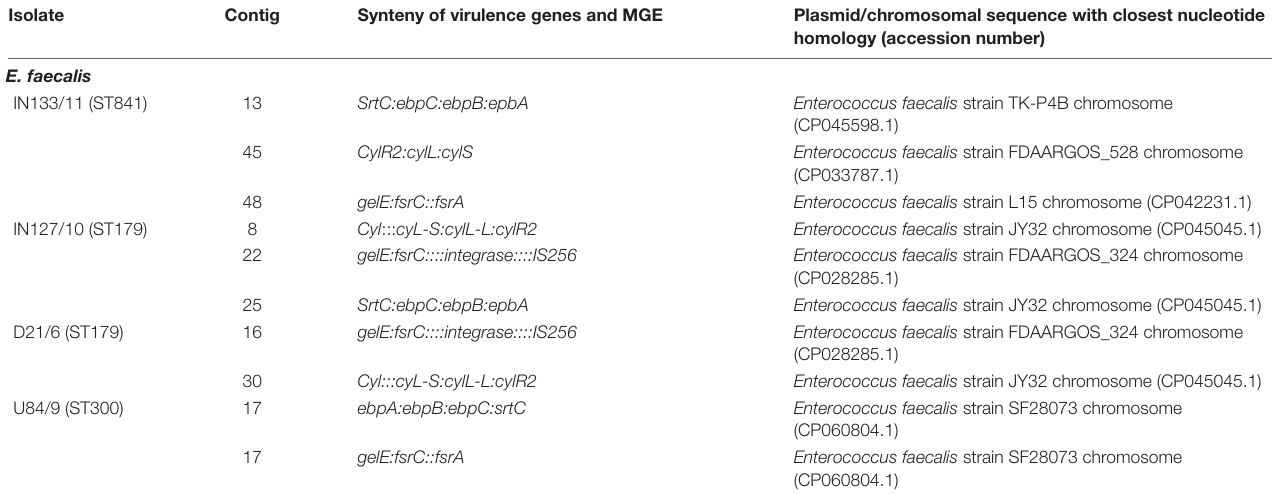
TABLE 5 | Mobile genetic elements associated with virulence genes in E. faecalis isolates. Isolate